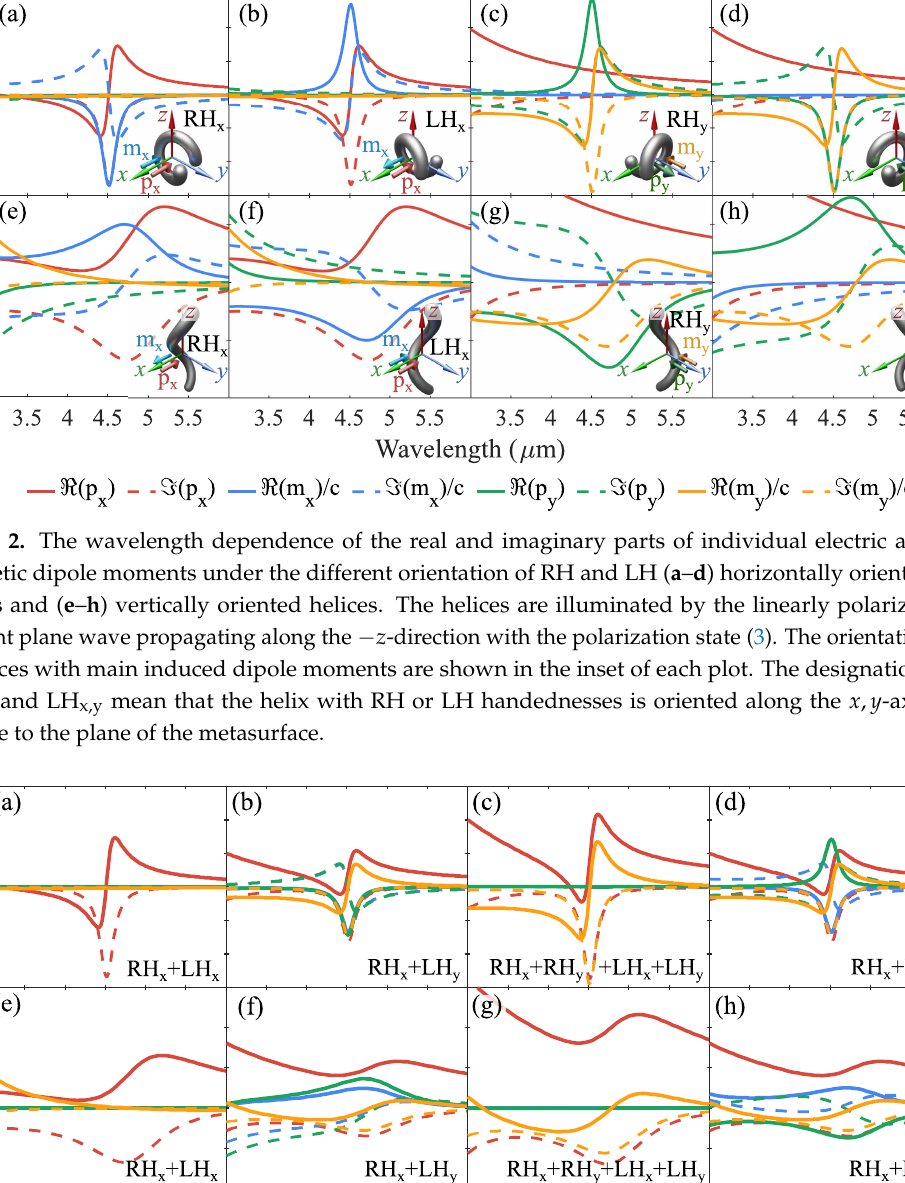
(Figure 3d). The same arrangement of vertically-oriented helices in the unit cell (Figure 3e–h) should be used to meet the conditions (6), (8), (10) and (12) for desired polarization conversions.